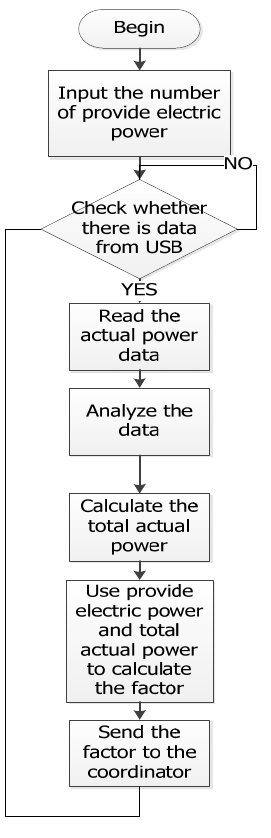
Figure 12. The activity diagram for the electricity control